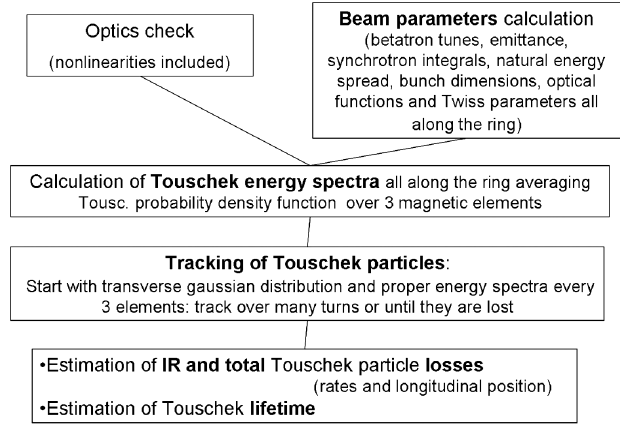
FIG. 2. Flowchart of the Monte Carlo simulation code STAR .